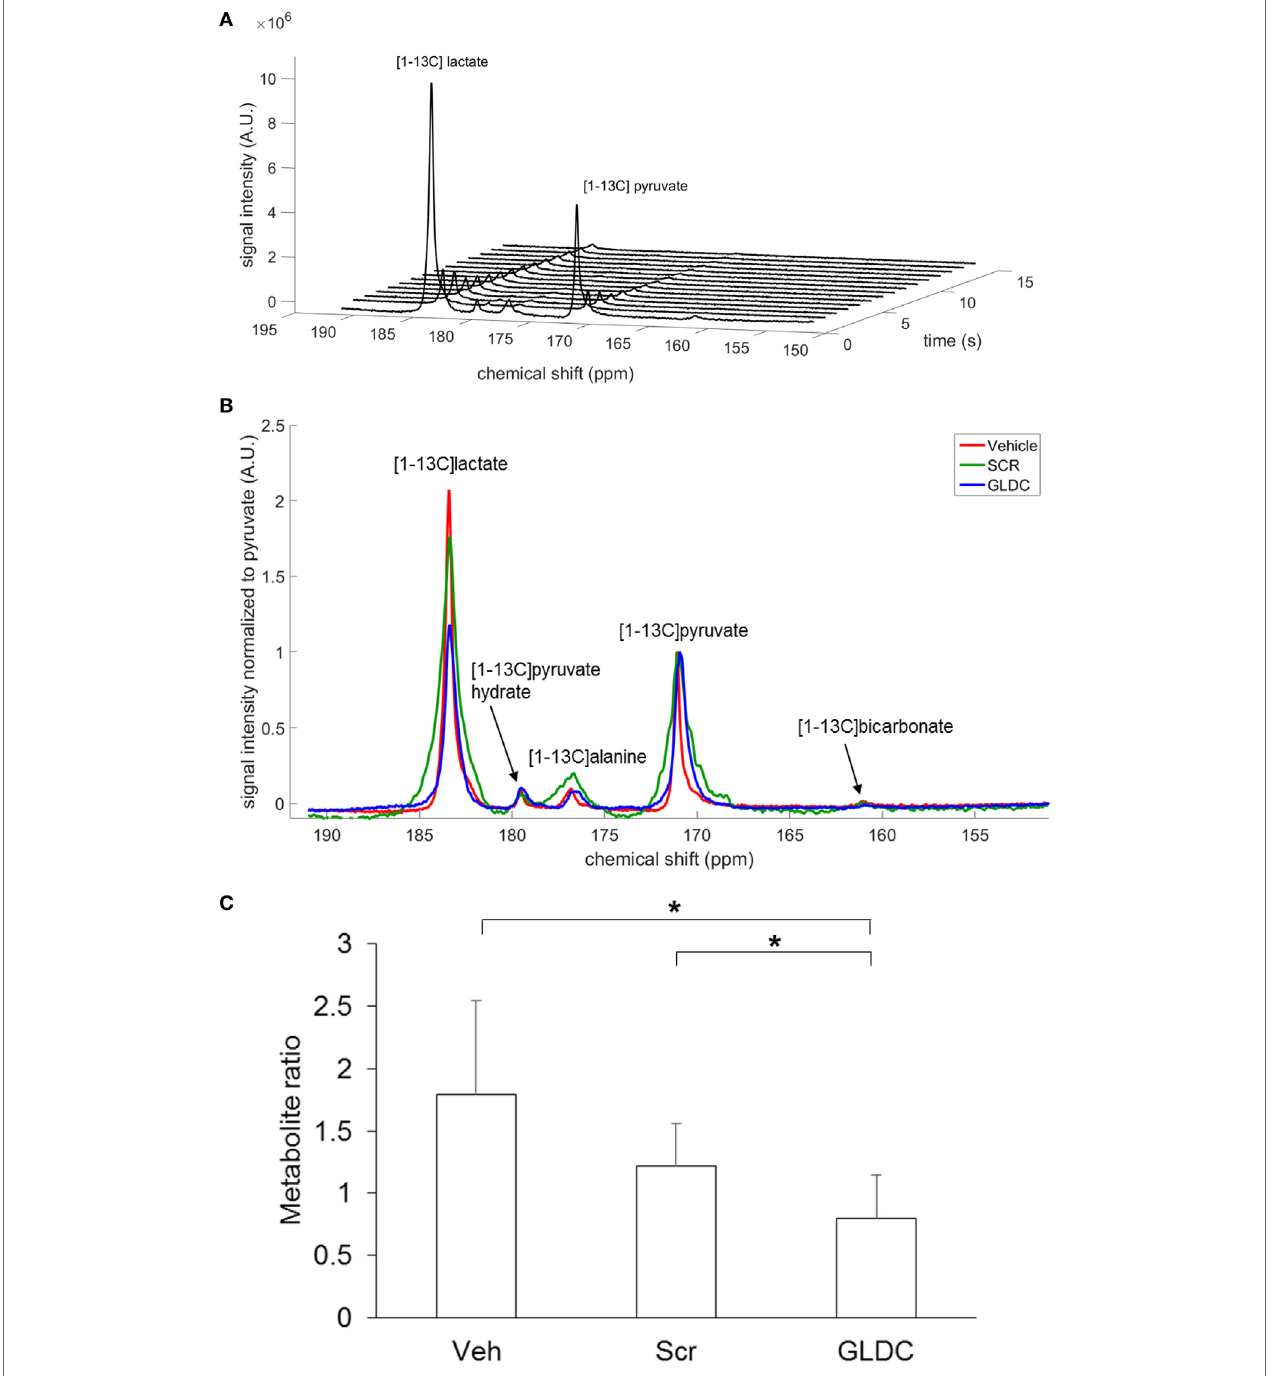
FigUre 4 | Detection of pyruvate metabolic products in the tumor using hyperpolarized 13 C MRS. (a) Dynamic in vivo tumor 13 C MR spectra over 1 min period after [1- 13 C]pyruvate injection, with a time resolution of 1 s. (B) Representative summed spectra over 10 s of all treatment groups. (c) Signal quantification of [1- 13 C] lactate after normalization to total carbon. Data represent mean ± SD (* p <